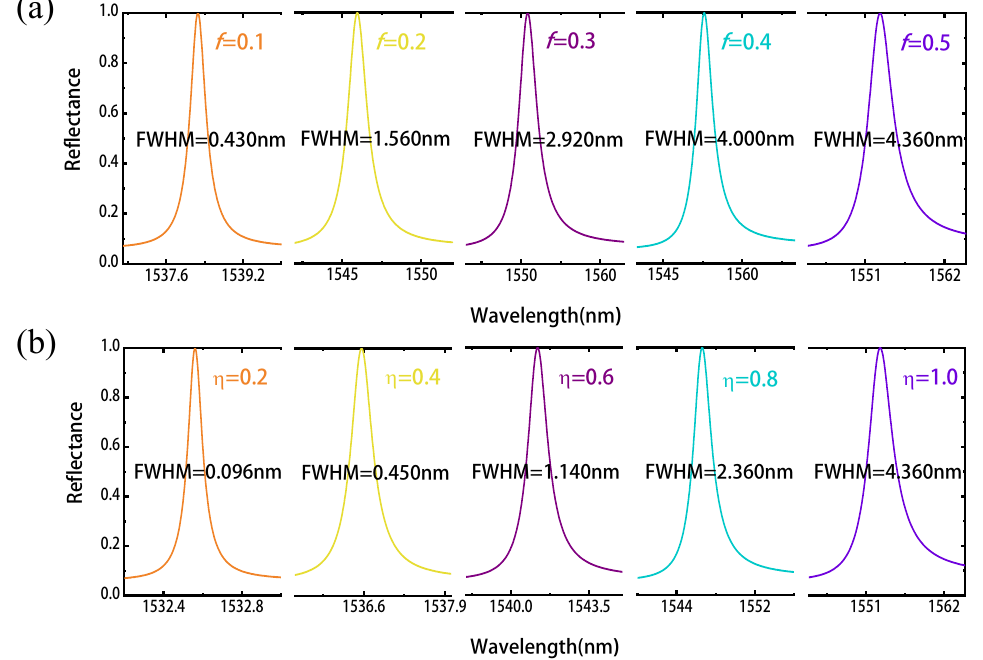
Figure 3. The reflection spectra of the Sb 2 S 3 -LN metasurface with different duty cycle f (with the crystallization fraction η fixed on 1) and different crystallization fraction η (with the duty cycle f fixed on 0.5) of the Sb 2 S 3 subwavelength grating. ( a ) As the duty cycle f decreases from 0.5 to 0.1, the peak of the reflection spectrum shifts to the shorter wavelength, and the FWHM of the structure decreases. ( b ) As the crystallization fraction η decreases from 1 to 0.2, the peak of the reflection spectrum shifts to the shorter wavelength, and the FWHM of the structure